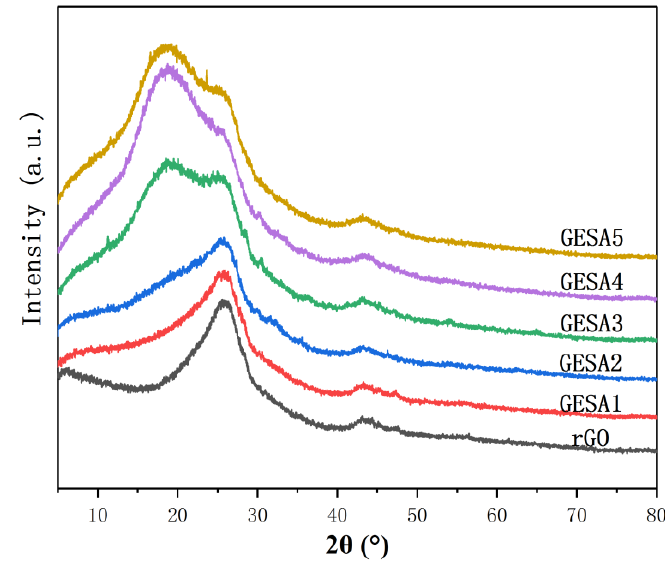
Figure 2. XRD diffractograms of rGO, GESA1, GESA2, GESA3, GESA4, and GESA5 composites.